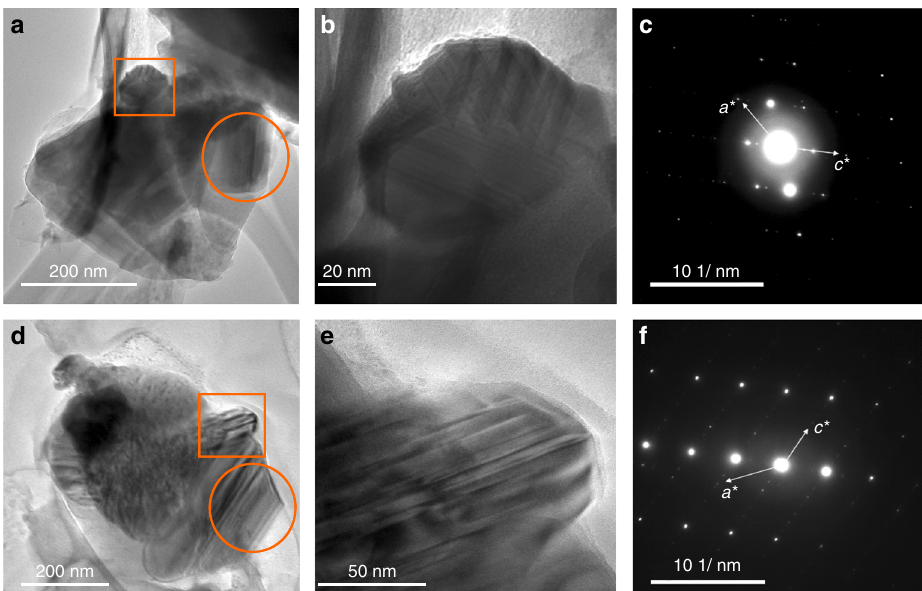
Fig. 1 Identi fi cation of Magnéli phases in environmental and industrial samples. a TEM image of Ti x O 2 x − 1 in a Dan River downstream sediment sample. b A magni fi ed TEM image of the square selected area in a . c Selected area electron diffraction ( SAED ) pattern of the circular selected area in a . Vectors a * and c * denote two of the principal crystallographic axes of Magnéli phases in reciprocal (diffraction) space (see Fig. 2 and associated text). d TEM image of Ti x O 2 x − 1 in coal ash collected from the coal ash impoundment. e A magni fi ed TEM image of the square selected area in e . f SAED pattern of the circular selected area in d